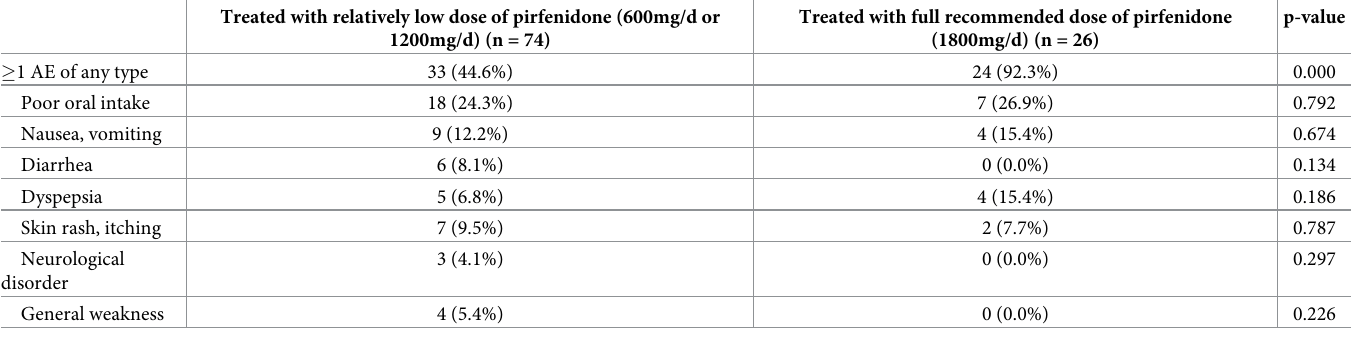
Table 8. Comparison of incidence of adverse events between patients who were treated with full recommended dose of pirfenidone (1800mg/d) and relatively low dose of pirfenidone (600mg/d or